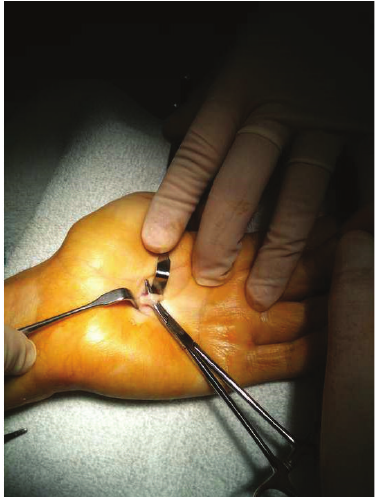
Figure 4: Intraoperative view of the lesion showing that the mass in the palm was originated from the common digital nerve of the 3rd and the 4th